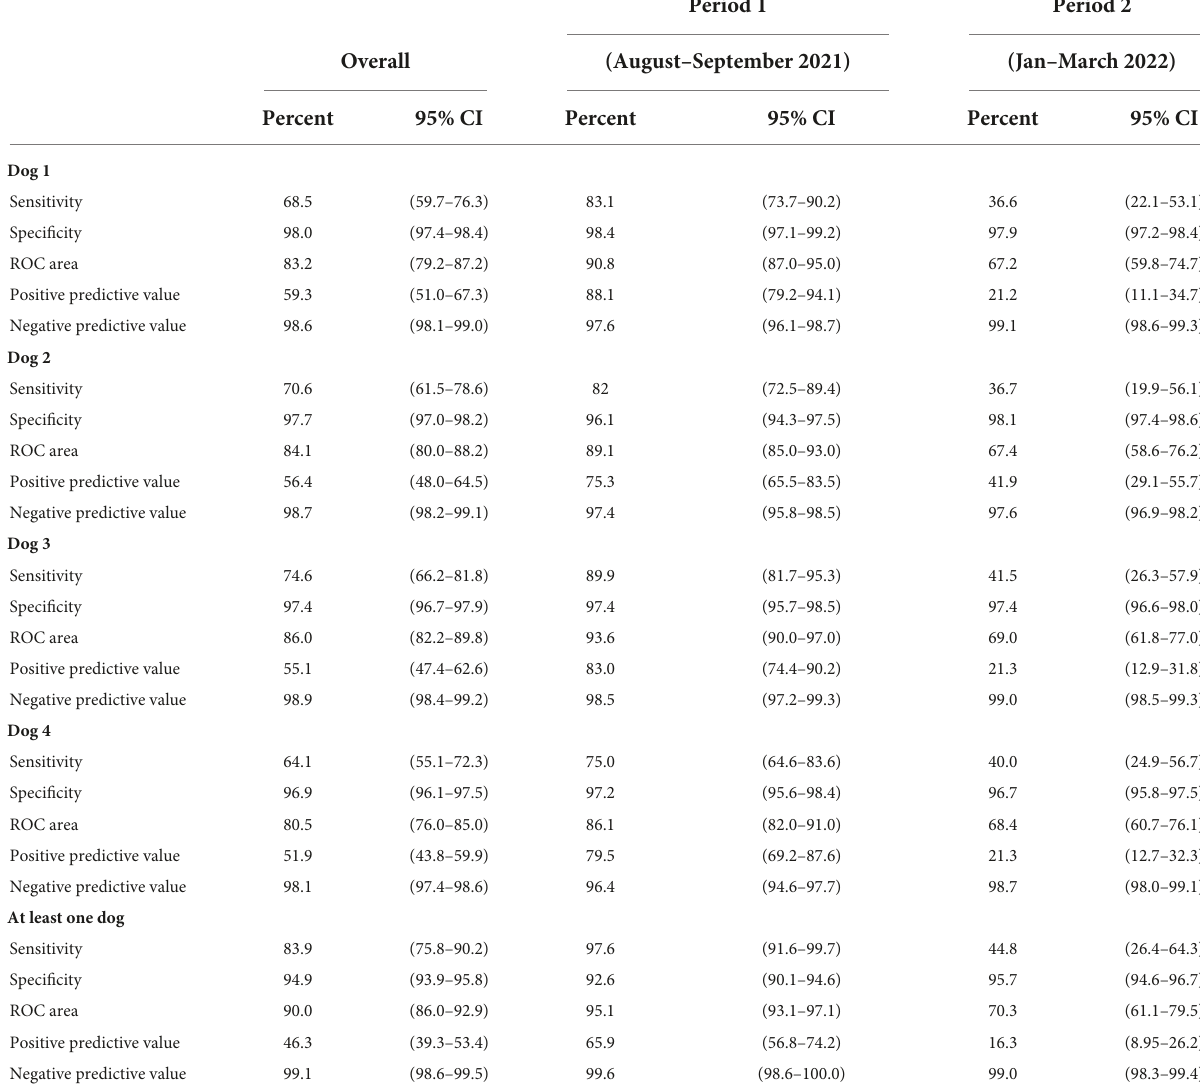
TABLE 3 The detection dogs’